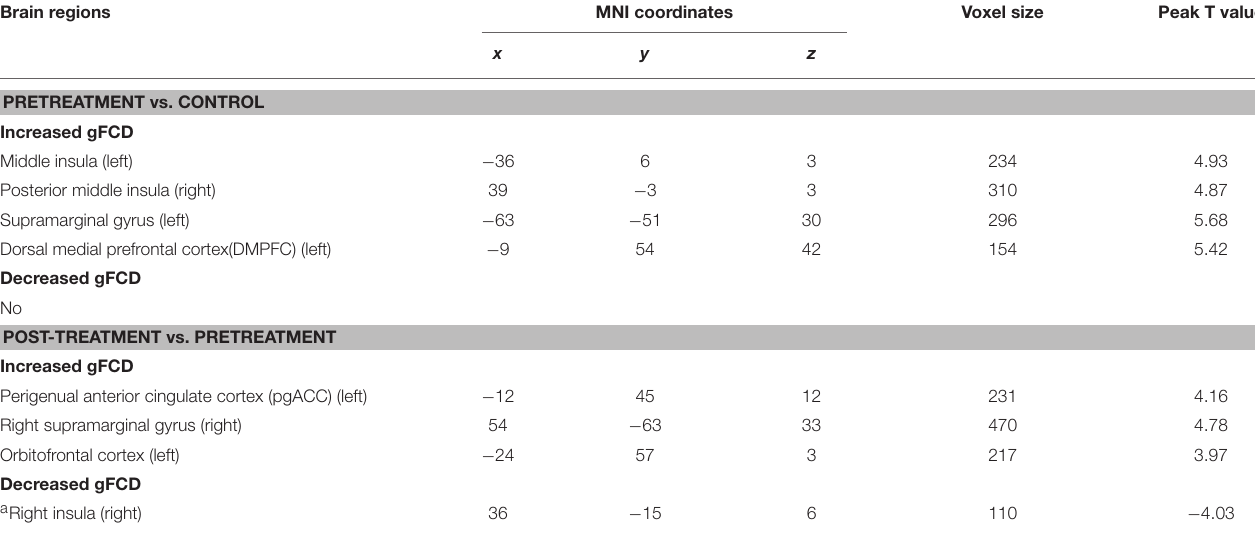
TABLE 2 | Significant difference between different groups in global functional connectivity density (gFCD). Brain regions MNI